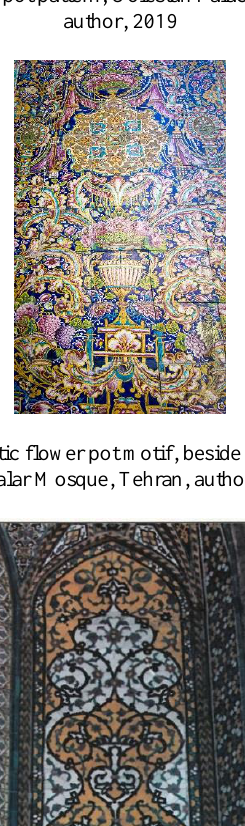
Figure 1. flower pot pattern, Golestan Palace walls, Tehran,